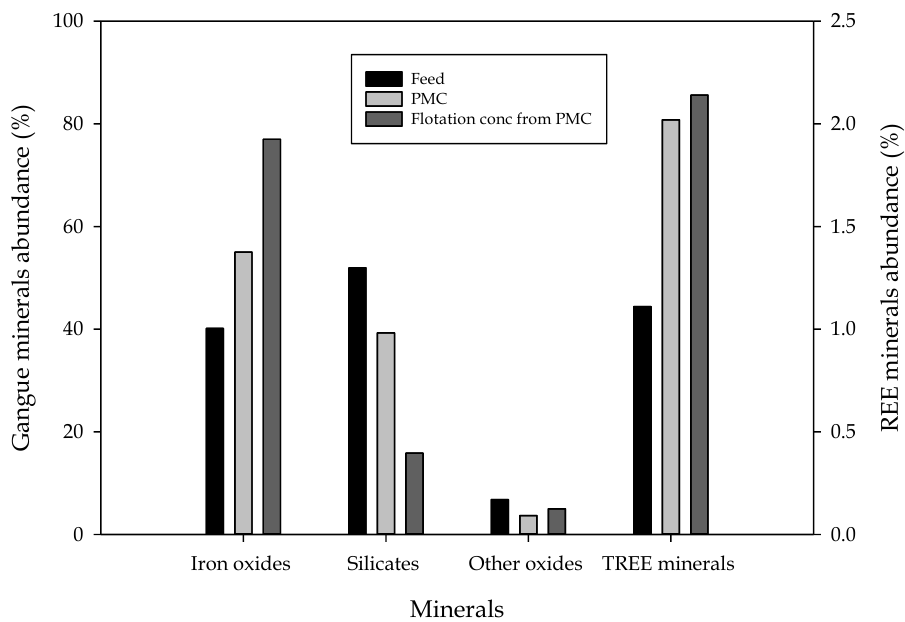
Figure 8. Mineral mass abundance of TREE and gangue minerals in the feed, magnetic preconcentrate (PMC), and flotation concentrate from PMC using hydroxamic acid.